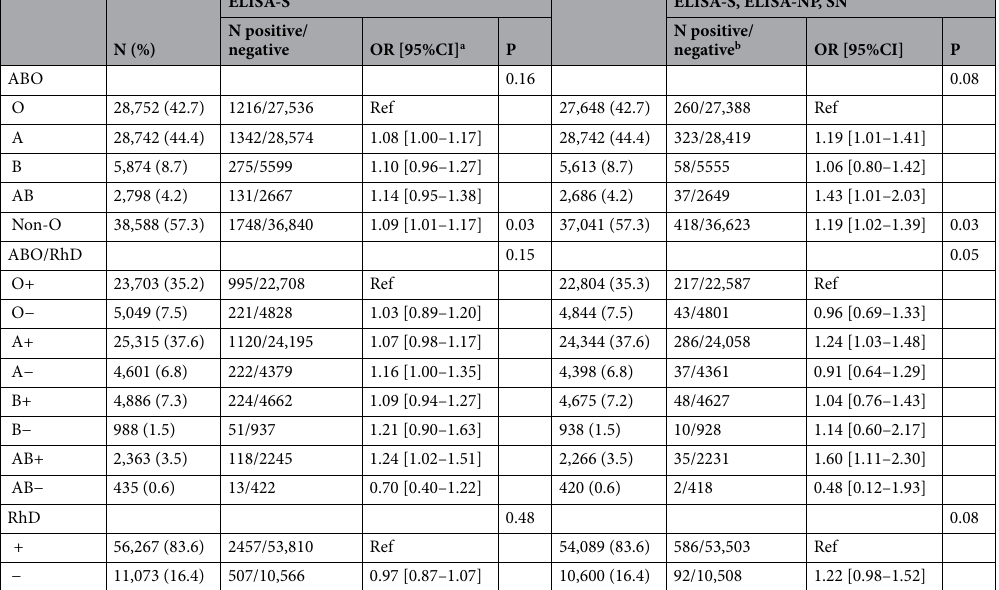
Table 2. Associations between ABO and RhD blood types and the seroprevalence of anti-SARS-CoV-2 antibodies, SAPRIS-SERO multi-cohort study, 2020. a OR and 95%CI obtained from a multi-adjusted logistic regression model stratified by cohort and including the following covariates: sex (men/women), age (< 40ans, 40–49, 50–59, 60–69, ≥ 70 years old), month of blood collection, residential area during the lockdown: city size (rural, < 20,000, 20–10,000, ≥ 100,000 inhabitants) and French administrative region. b A participant was considered positive (respectively negative) if positive (respectively negative) to all three ELISA-S, ELISA-NP, and SN tests. Among the N = 2964 individuals with a positive seroprevalence of anti SARS Cov-2 antibodies according to the ELISA-S test, N = 1185 were also positive according to the ELISA-NP test and 678 were positive according to all three ELISA-S, ELISA-NP, and SN